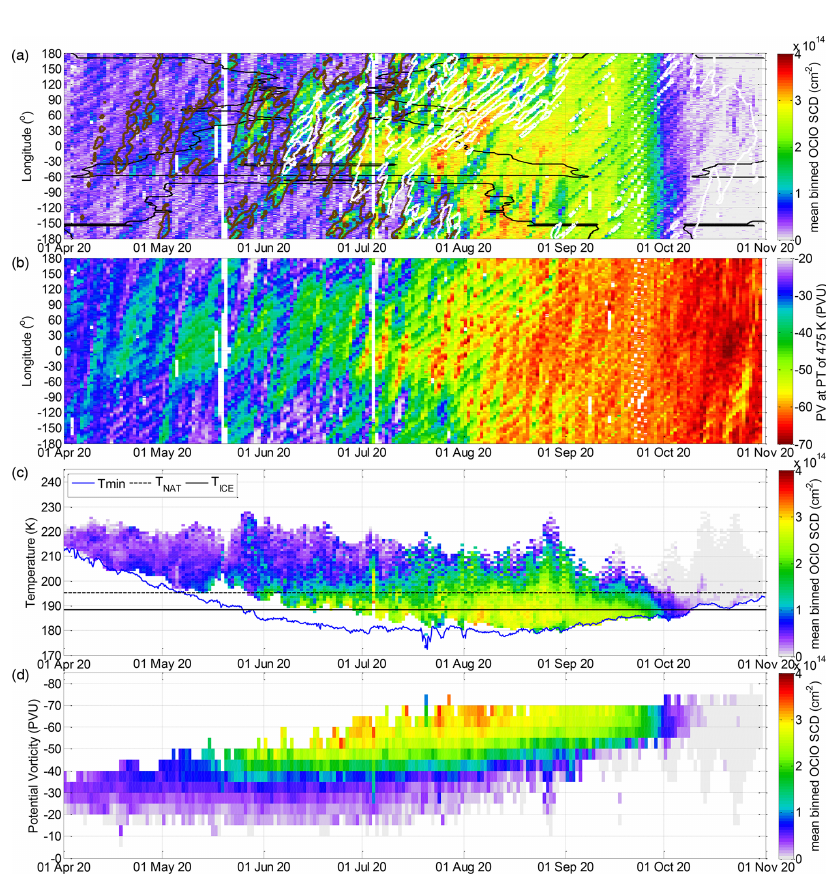
Figure 17. Same as Fig. 11 but for the Antarctic winter 2020.